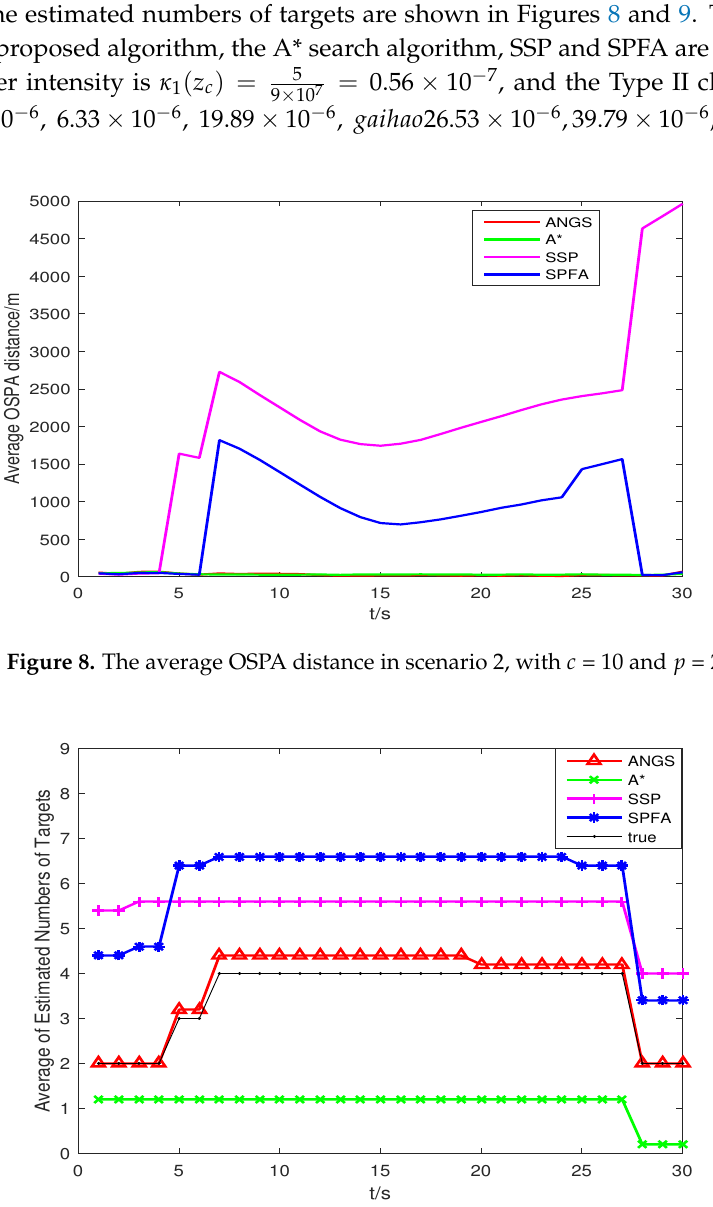
Figure 9. The average of the estimated numbers of targets in scenario